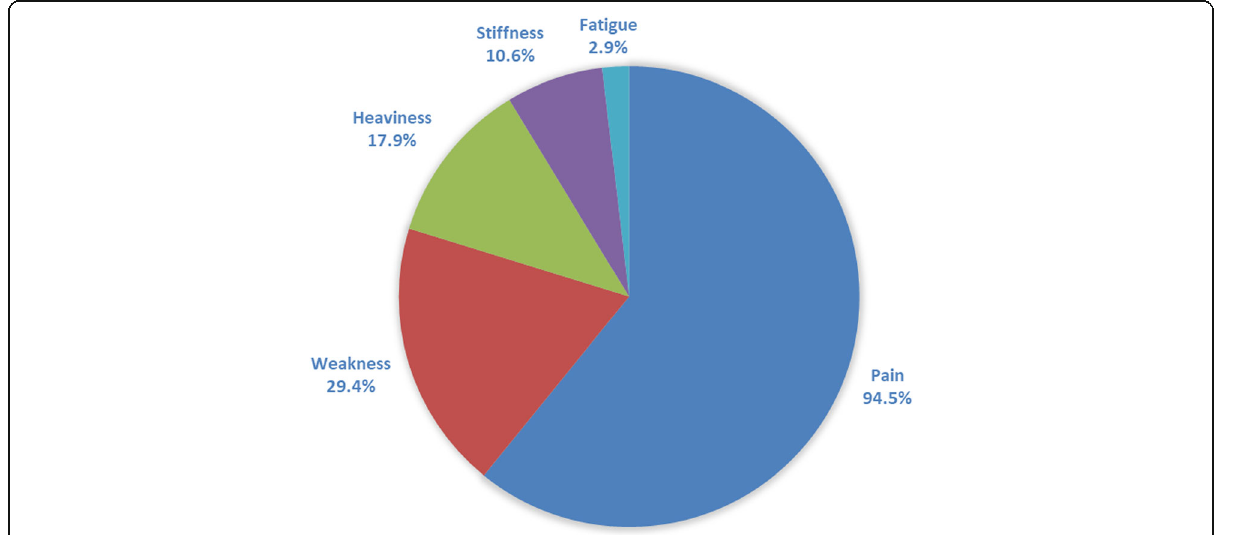
Fig. 2 Symptoms of WMSDs in the study